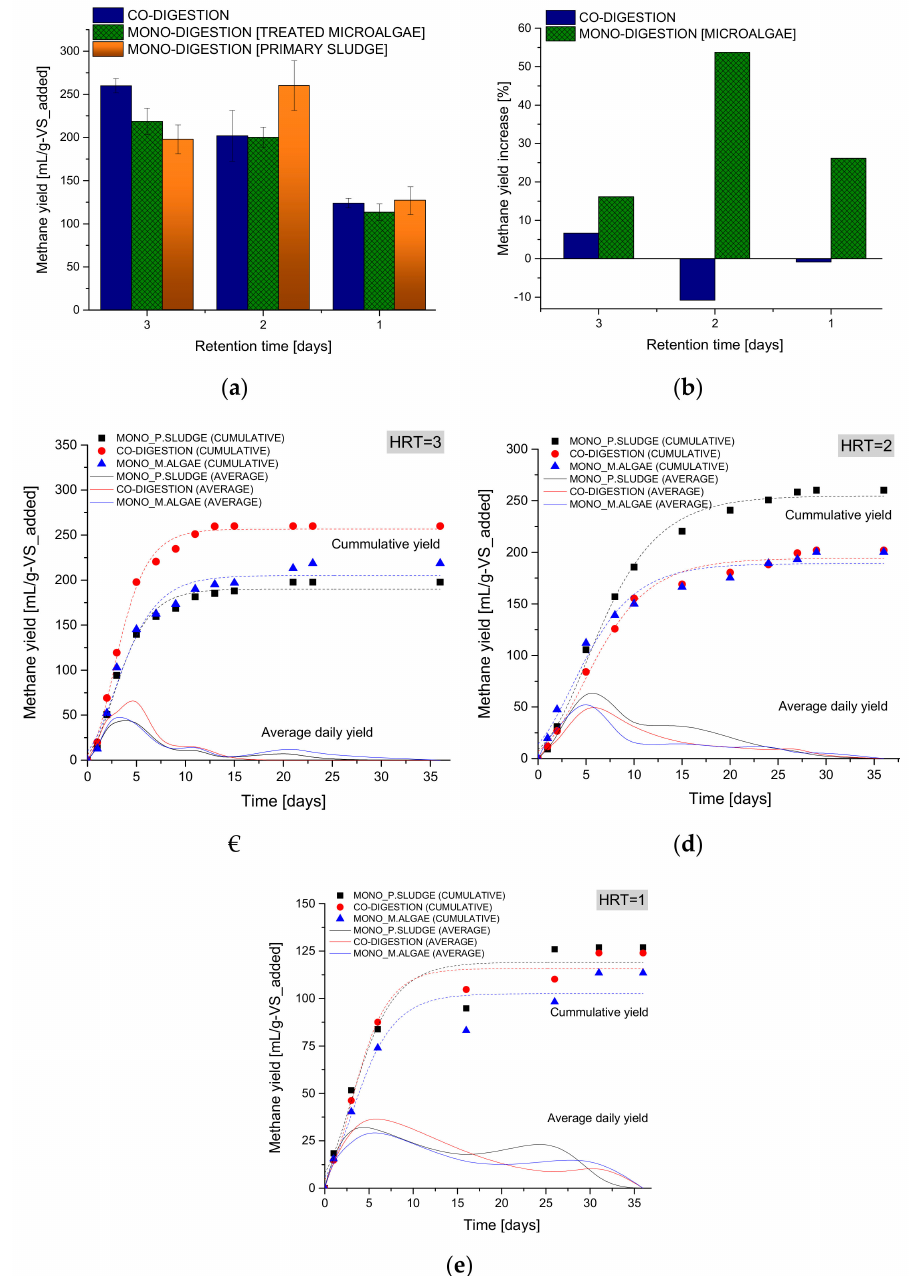
Figure 4. Methane yield at di ff erent HRTs after anaerobic biological pretreatment: ( a ) experimental maximum yield; ( b ) percentage increase in methane yield as compared to no pretreatment condition; ( c – e ) experimental vs. simulated values at di ff erent HRTs [Experimental condition: Mesophilic AD temperature = 35 ◦ C, Sludge / algae ratio for co-digestion = 9, pH = 7.1 ± 0.2, ISR = 2, Working AD volume = 150